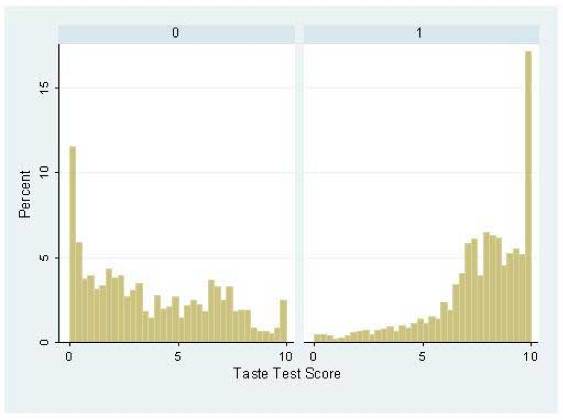
Distribution of PROP taste test scores by genetic prediction of tasting ability in the ALSPAC cohort. Test groups here correspond to 0 = non-tasters as defined by the homozygous carriage of the TAS2R38 haplotype AV; 1 = tasters as defined by the homozygous or heterozygous carriage of the TAS2R38 haplotype PA. Ranksum analysis for comparison of random points from these two distributions yields p =< 0.001.